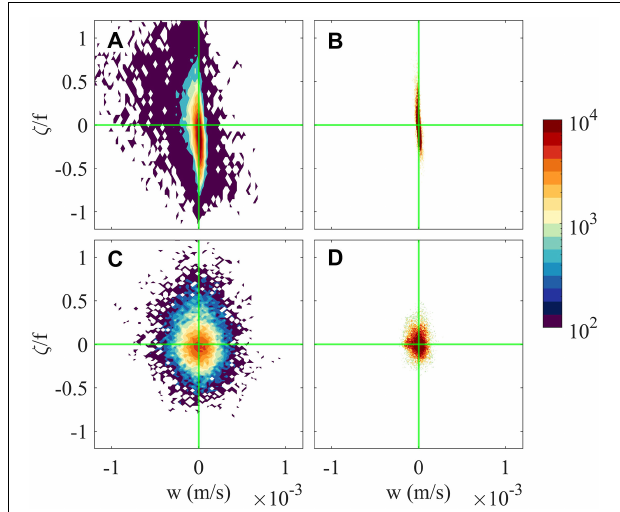
FIGURE 11 | Joint probability density function of vertical velocity and relative vorticity based on particles position 24 h after deployment in the SP (A,C) and MR (B,D) simulations, for surface (A,B) and type 2 (C,D) releases. Green lines indicate values of zero. The distributions are calculated using the first SP and MR releases in